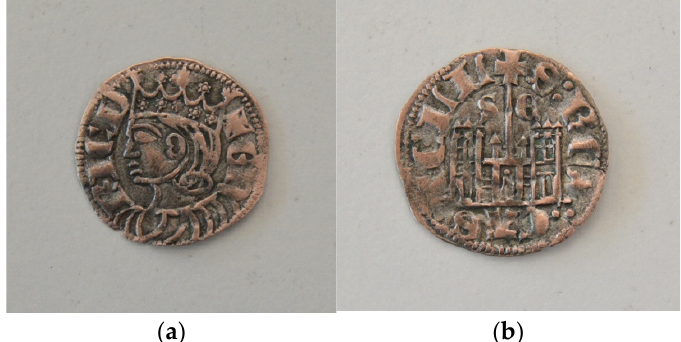
Figure 4. Vellón coin issued by Henry II. Billon coin. After 1373. Archaeological Museum of Cór- Figure 4. Vell ó n coin issued by Henry II. Billon coin. After 1373. Archaeological Museum of C ó rdoba. doba. © Archaeological Museum of Córdoba, Spain: ( a ) Front; ( b ) Back. © Archaeological Museum of C ó rdoba, Spain: ( a ) Front; ( b )